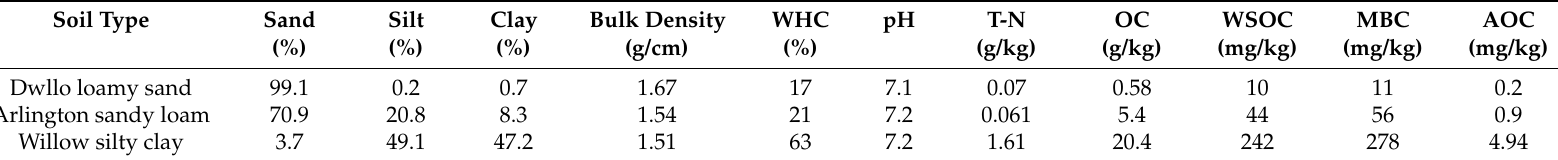
Table 1. Soils texture and